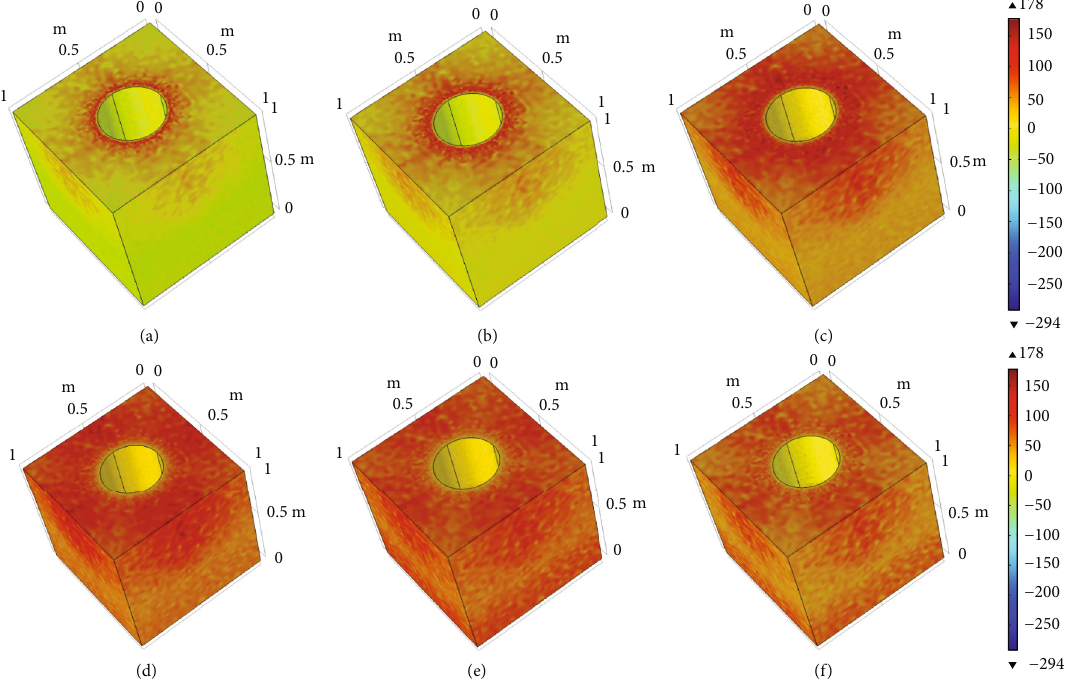
Figure 18: Stress fi eld in the m = 5 coal rock: (a) t = 0 : 1 s, (b) t = 1 × 10 3 s, (c) t = 1 × 10 4 s, (d) t = 1 × 10 5 s, (e) t = 1 × 10 6 s, and (f) t = 1 × 10 7 s.